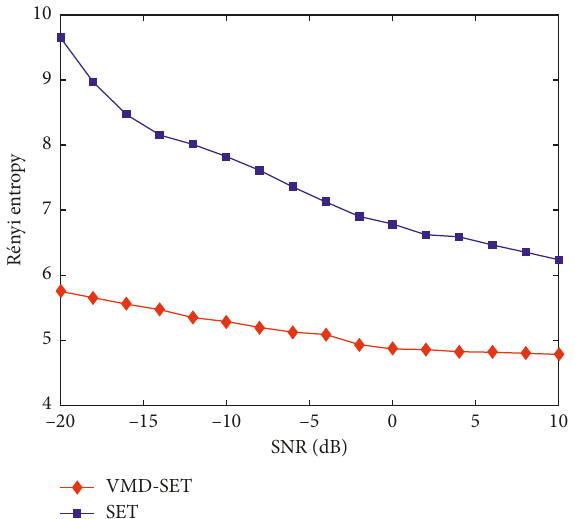
Figure 16: The R´enyi entropies of the time-frequency representation based on SET and VMD-SET under different SNR (SFM).